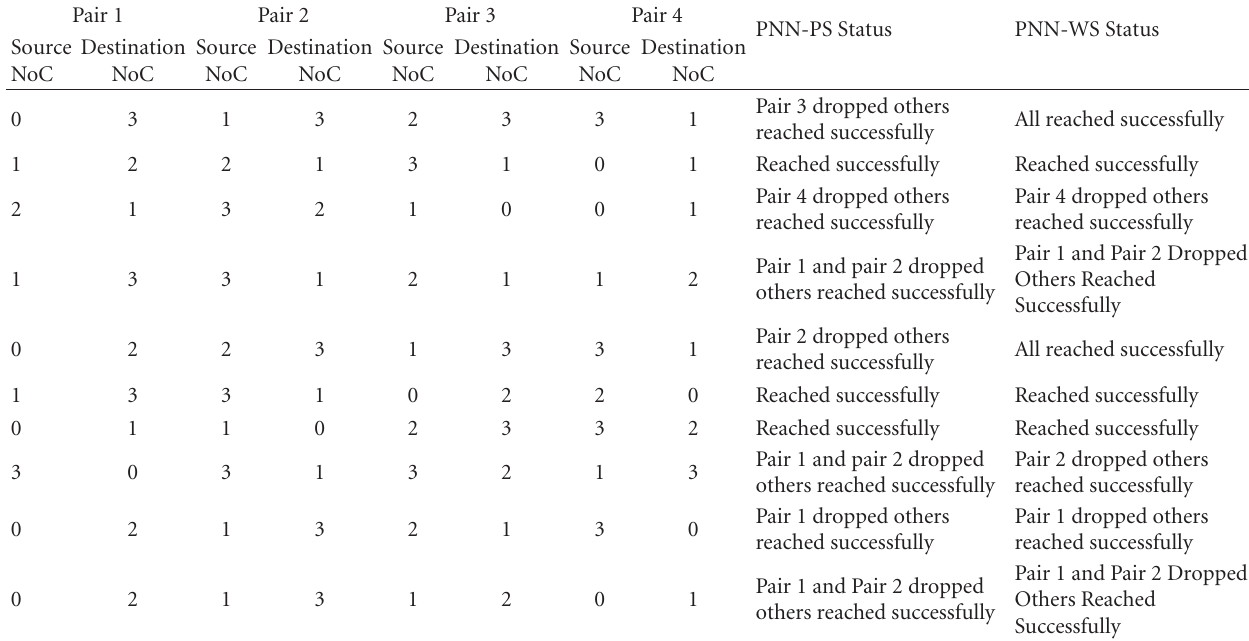
Table 26: The following source destination pairs of NoCs are used to show 75% and 82.5% e ffi ciency of the NiP (based on HXN, used as IoC). All source destination pairs delivered the information to the respective NoCs. The following data does reflect the parallel communication among the NoC using packet and wormhole switching algorithms. Some of the payload information are dropped in the network due to non-availability of paths.